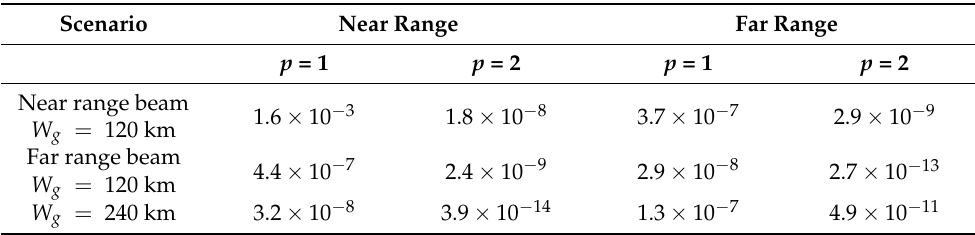
Table 4. Probability of detection of the first- and second-order range ambiguities of a large ship of 300 m × 20 m size for the different